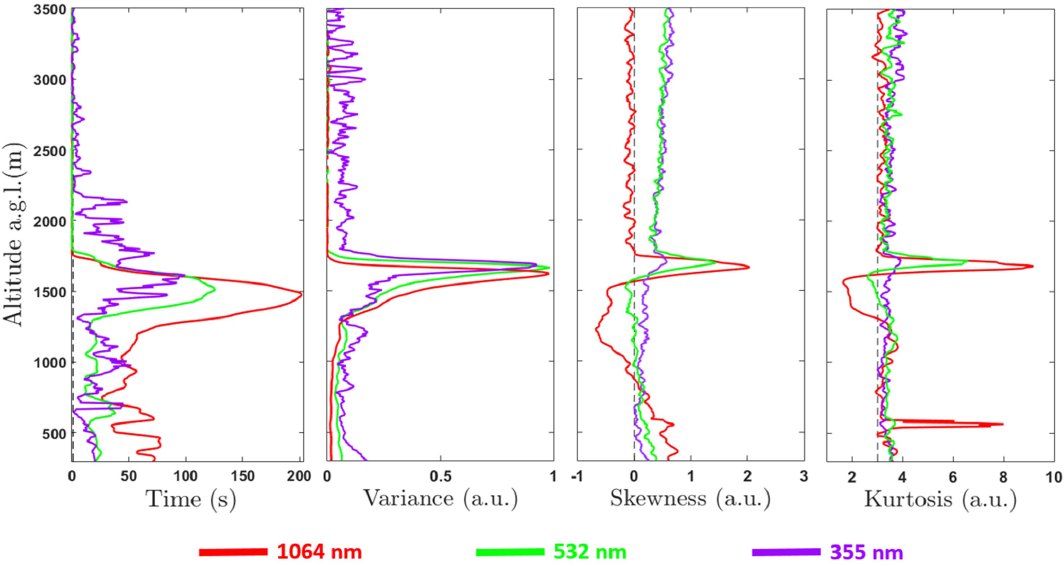
Figure 12. High-order moments corrected by first lag correction at 1064 (red line), 532 (green line) and 355nm (violet line) on 19 July 2018 from 18:00 to